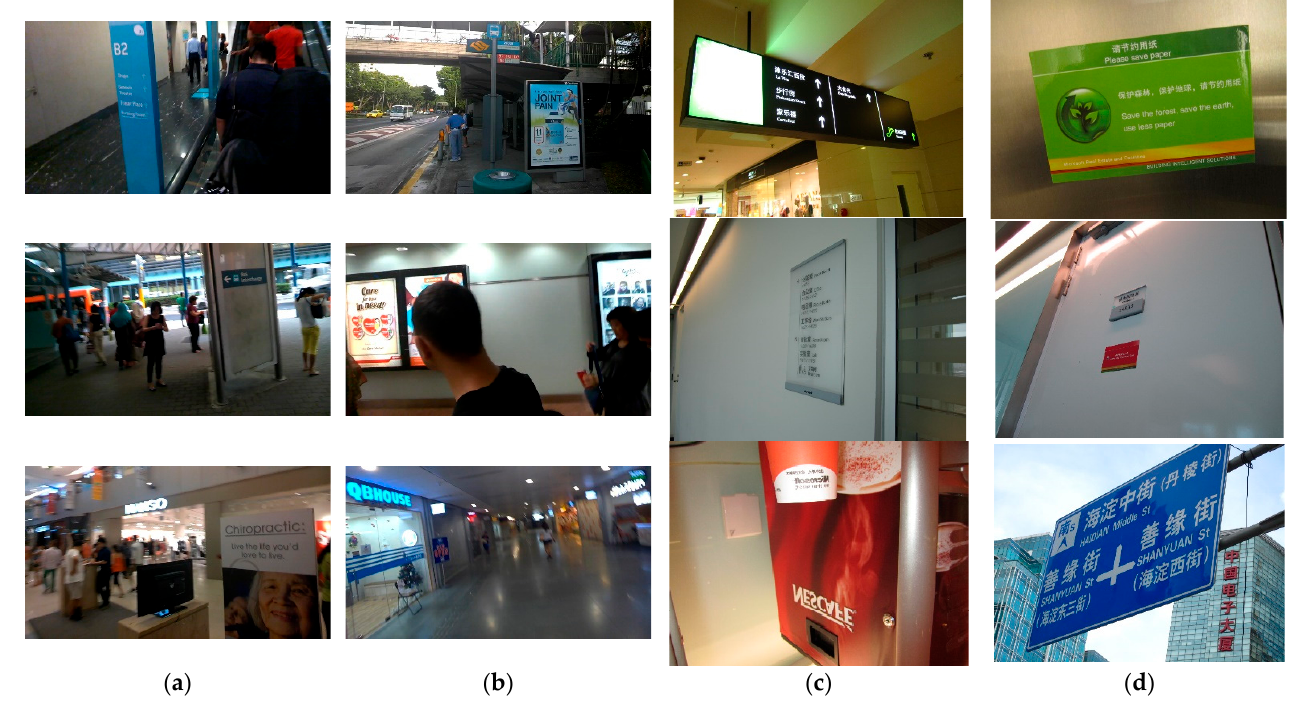
Figure 4. Some samples of the datasets. ( a ) From the ICDAR2015 training set; ( b ) from the ICDAR2015 test set; ( c ) from the MSRA-TD500 training set; ( d ) from the MSRA-TD500 test set.